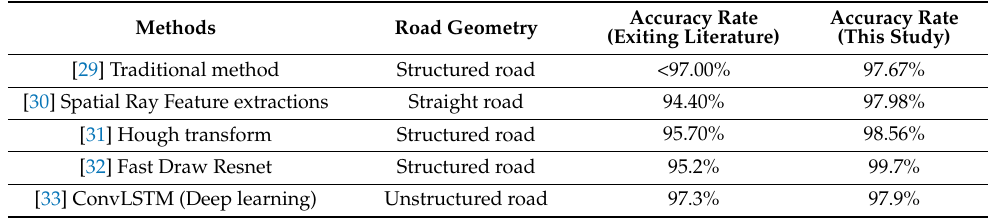
Table 5. Comparison of our results with existing